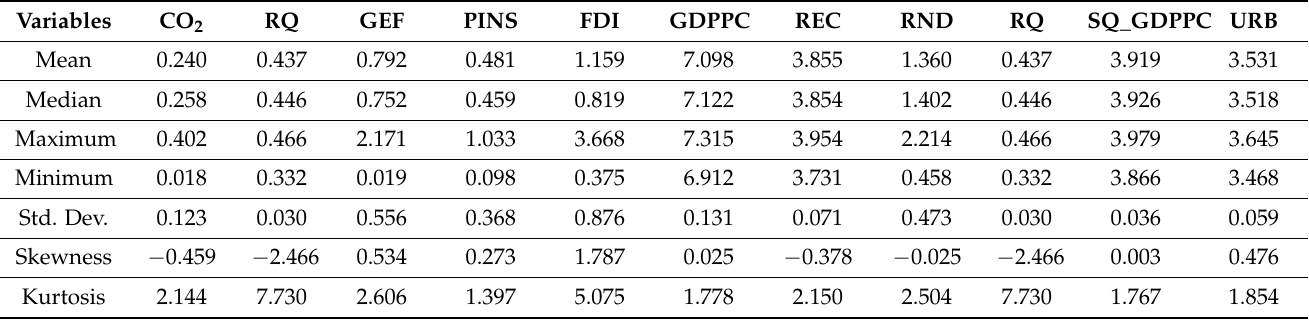
Table 2. Descriptive Statistics (with natural